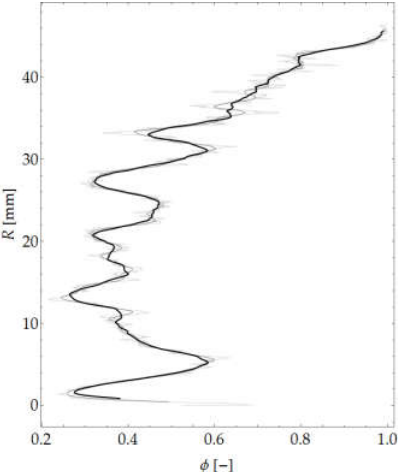
Figure 34. Graph of mortar content along sample height.